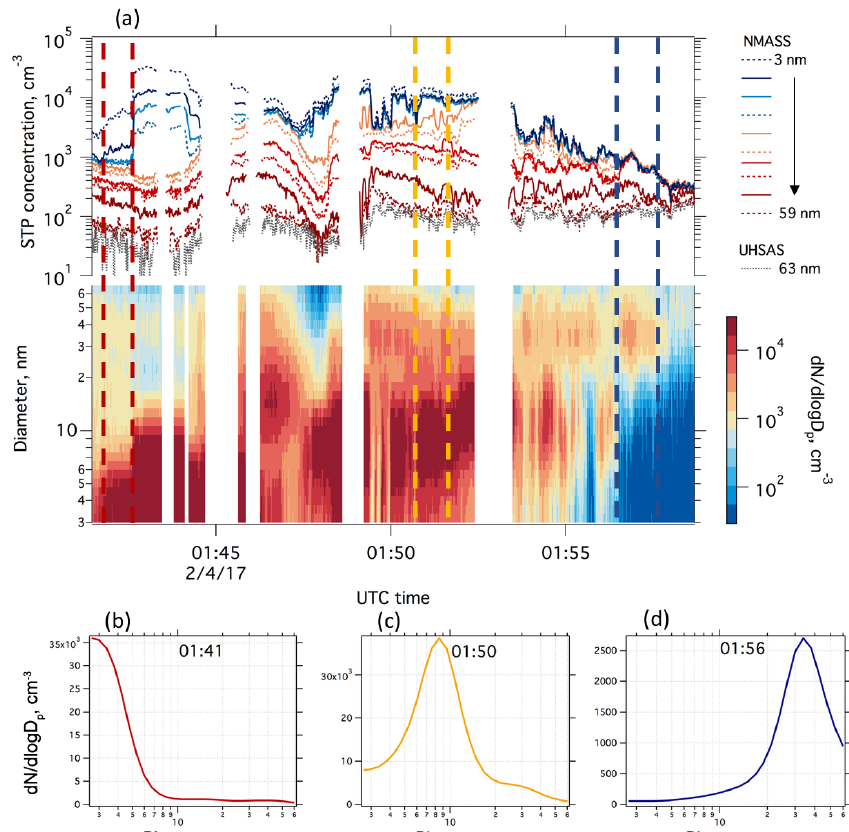
Figure 12. Example data taken on the NASA DC-8 aircraft during ATom in February 2017. The top of panel (a) shows the STP number concentrations measured by each channel of both NMASSs, as well as the total concentration of particles from 63 to 1000nm measured by the UHSAS, which is used to constrain the inversion. The bottom of panel (a) shows the inverted size distribution. Panels (b) , (c) , and (d) show an average of 1min of data (shown by the dashed vertical lines of the corresponding colours in panel a ) at the 3 times to show different example size distributions. Recent new particle formation produced high concentrations of small particles at 01:41, as indicated by the large difference in particle number concentration between the NM1 CPC 1 and 2 in panel (a) , corresponding to a mode diameter in the size distribution below 3nm. At 01:50, most particles are larger, as shown by the broad spacing of the middle diameter CPC concentrations in the top panel, and the mode diameter around 8nm in the lower two panels. At 01:56 (d) all of the lower diameter channels measure the same concentration, as seen in panel (a) , and the mode diameter increases to around 40nm in the size distribution. Gaps in the data are where the aircraft flew through cloud, which can cause artefacts, and so NMASS and UHSAS data are removed